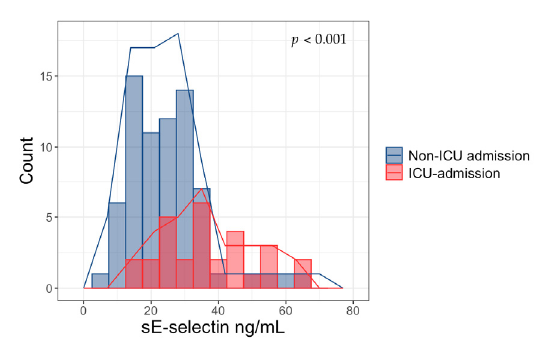
Figure 1. Serum E-selectin levels in non-survivors and survivors ( A ), in patients with thrombotic events and those without thrombotic events ( B ) and in ICU and non-ICU-admitted patients ( C ). ICU: intensive care unit. Table 2. sE-selectin as predictor of ICU admission from Simple Logistic Regression. Table 1. Patient characteristics. Analysis